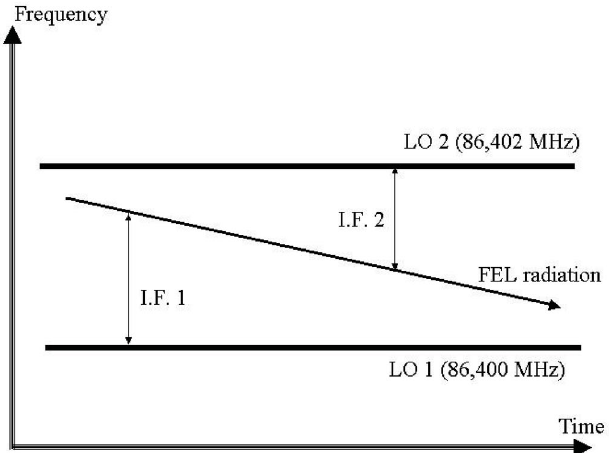
FIG. 4. Aliasing and chirp direction. If the radiation has nega- tive chirp (frequency drops down with time), the intermediate frequency (IF) signal will exhibit negative chirp only when its frequency f is higher than that of the local oscillator (LO): f > f . When f < f IF signal will exhibit a positive LO LO